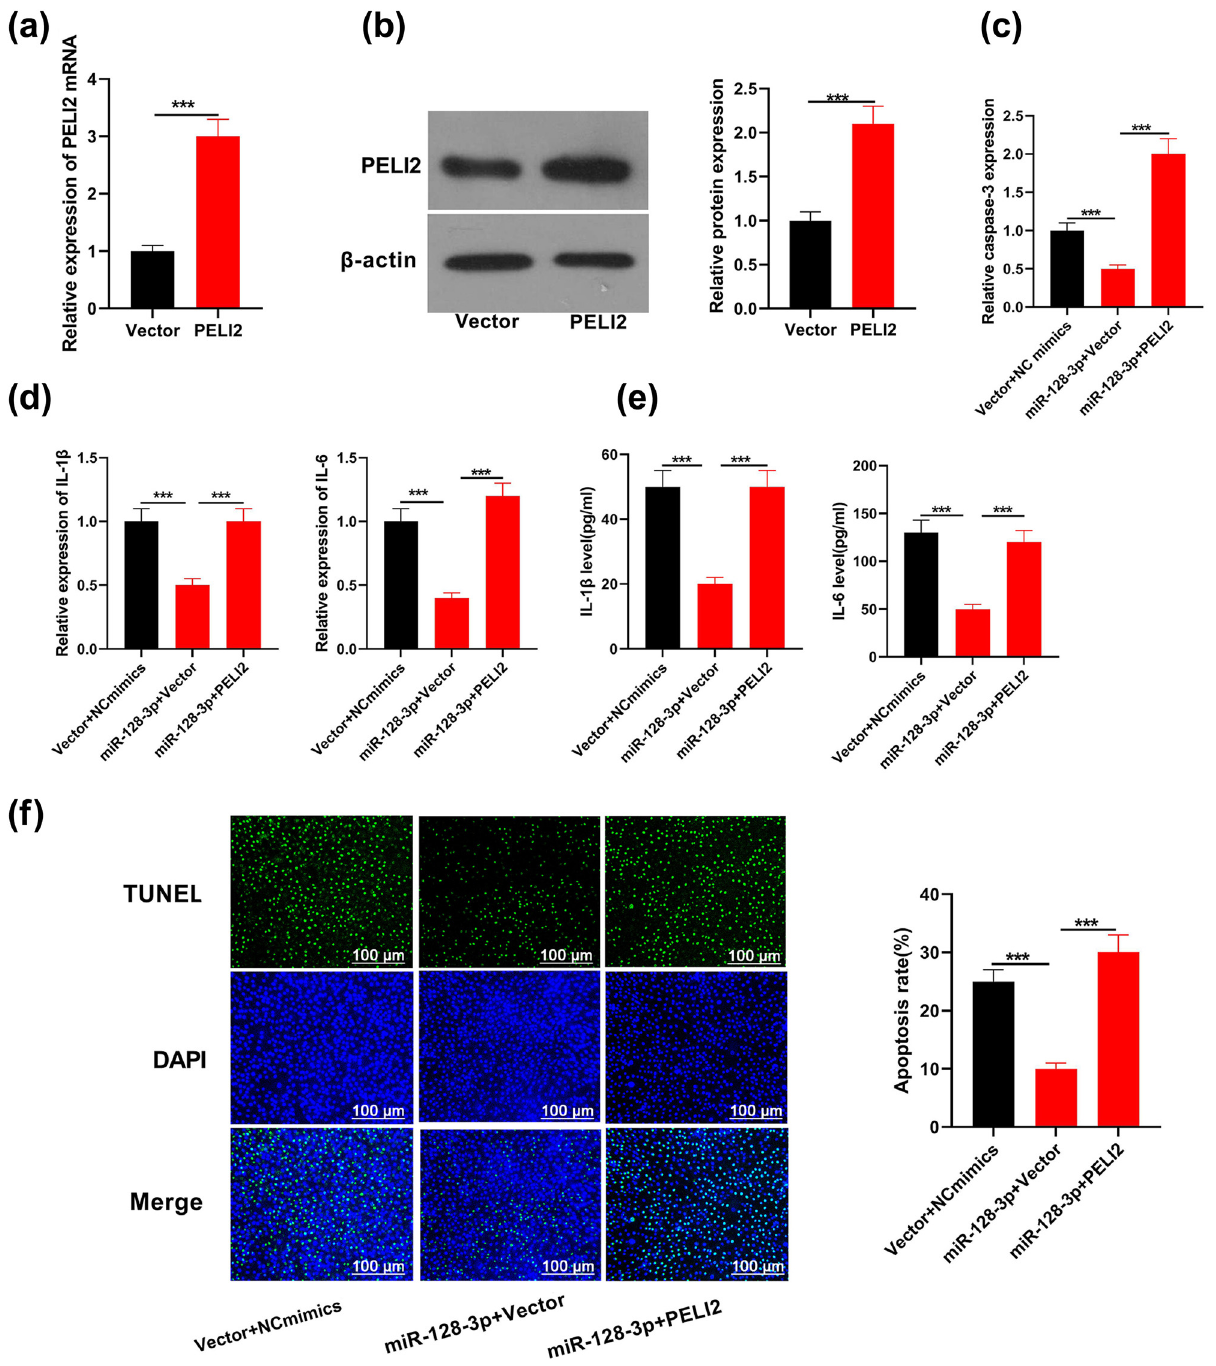
Figure 5: miR - 128 - 3p took part in cellular apoptosis and in fl ammation via PELI2. ( a and b ) PELI2 and its mRNA level in cells with high expression of PELI2 were measured using RT - qPCR. ( c ) Transcriptive activity of caspase - 3 in cells that were transfected both with mimics of miR - 128 - 3p and plasmids overexpressing PELI2 was determined using caspase - 3 assay kit. ( d ) RT - qPCR measured IL - 6 and IL - 1 β mRNA level within cells which were transfected both with mimics of miR - 128 - 3p and plasmids overexpressing PELI2. ( e ) IL - 6 and IL - 1 β in supernatant of cells that were cotransfected with mimics of miR - 128 - 3p in addition to plasmids overexpressing PELI2 was measured using ELISA. ( f ) TUNEL determined the apoptosis level in cells which were purely transfected with mimics of miR - 128 - 3p and plasmids overexpressing PELI2. *** P <